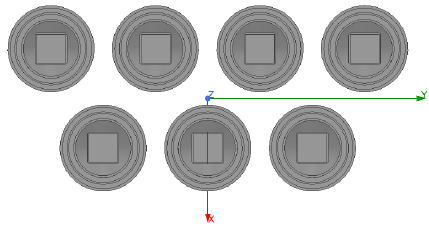
Figure 5. Surveillance planar array